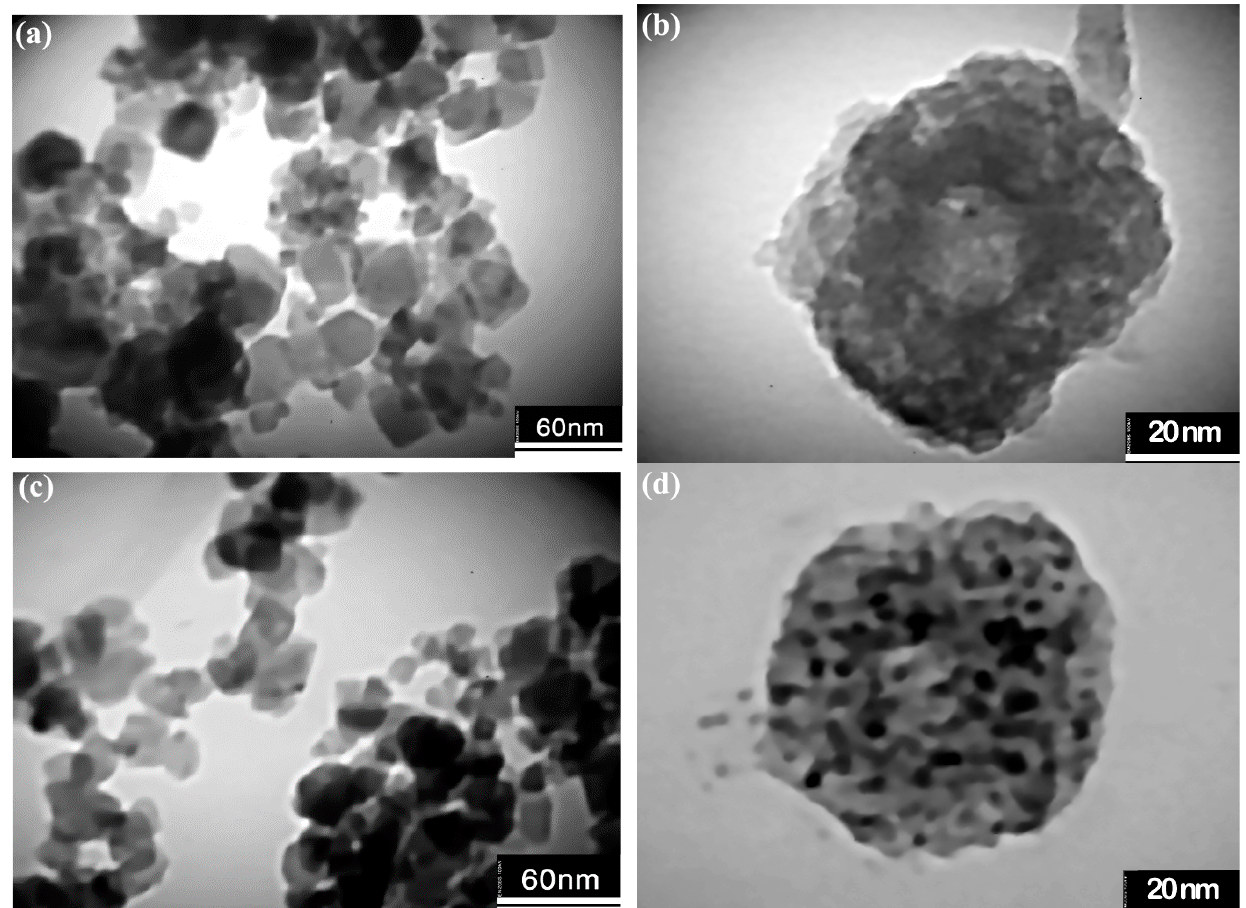
Figure 5. TEM micrographs of bare and PEG-coated MnZn ferrite nanoparticles, ( a , b ) with normal morphology, and, ( c , d ) with hierarchical morphology.